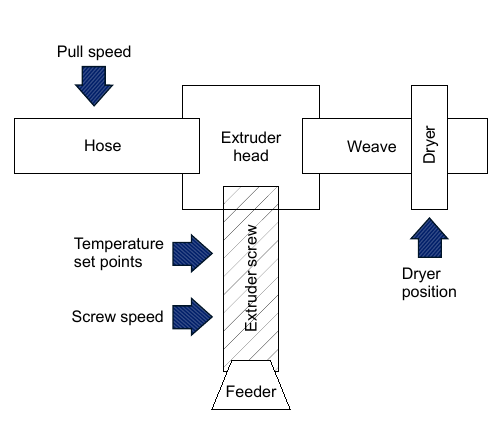
Figure 2: Sketch of input variable position The factor A: Temperature set point is actually a temperatures; the extruder screw has 4 zones